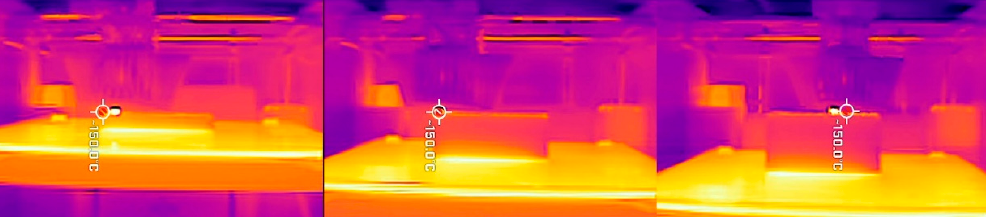
Figure 14. Temperature changes of a printout during printing. Notice that a vertical temperature distribution above some level did not change.